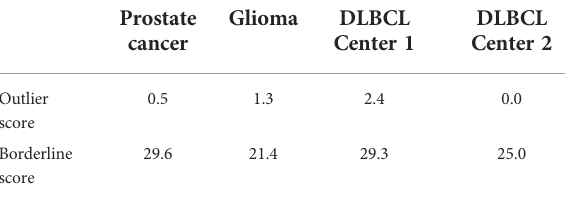
TABLE 2 Outlier and borderline score ratio across the MC folds of each analyzed